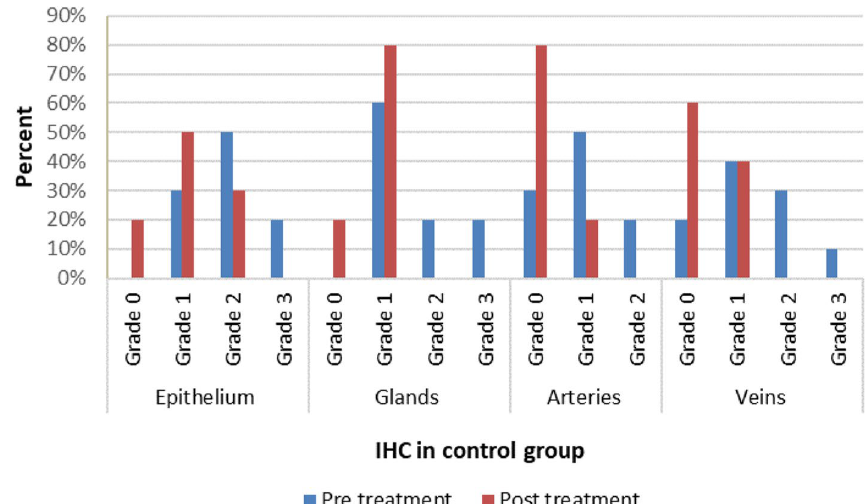
Fig. 5 Comparison between the pre- and post-IHC data among control